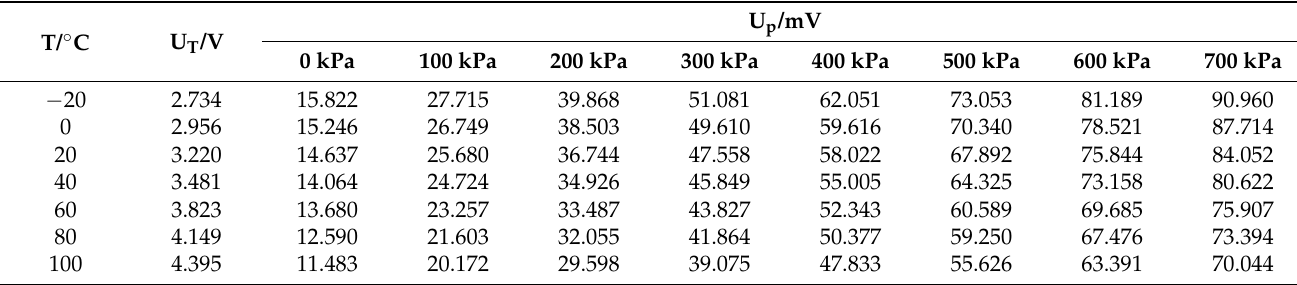
Table 3. Calibration results of Sensor